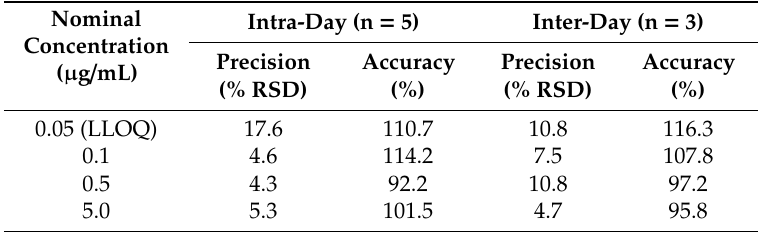
Table 3. Intra-day, inter-day precision, and accuracy of nominal concentrations.